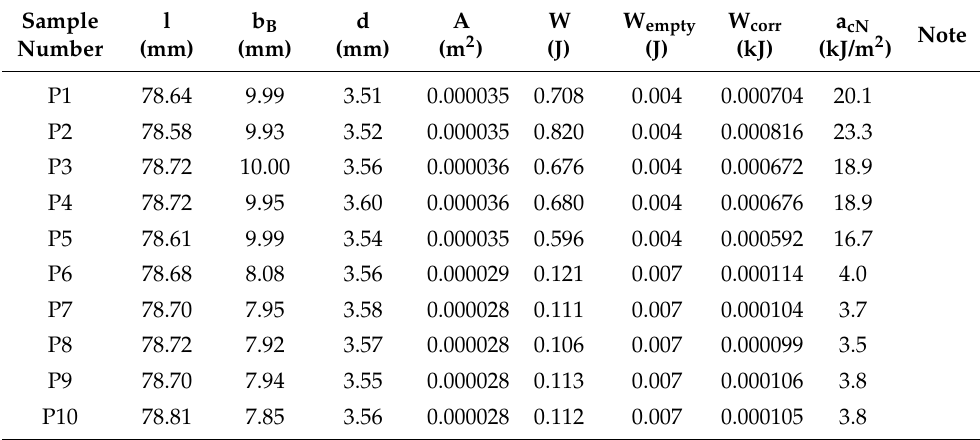
Table A23. Results of the notched impact tests and unnotched impact tests of PO_B,C.